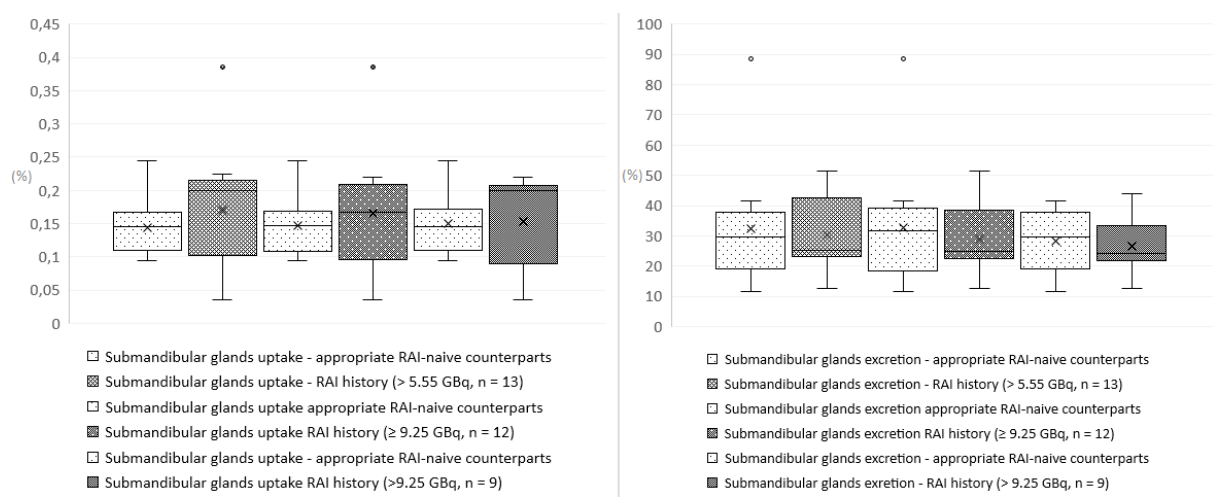
Fig. 3. Submandibular glands uptake (left) and excretion fraction (right) in patients treated with RAI activities >5.55GBq, ≥9.25 GBq and >9.25 GBq were